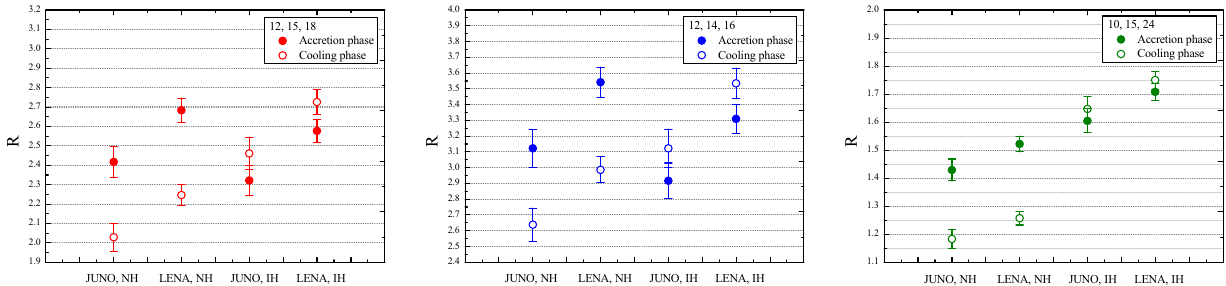
Fig. 3 Expected R values and uncertainties at JUNO and LENA detectors for both mass hierarchies. Each plot corresponds to a set of mean energies of different flavors denoted at the upper right corner in